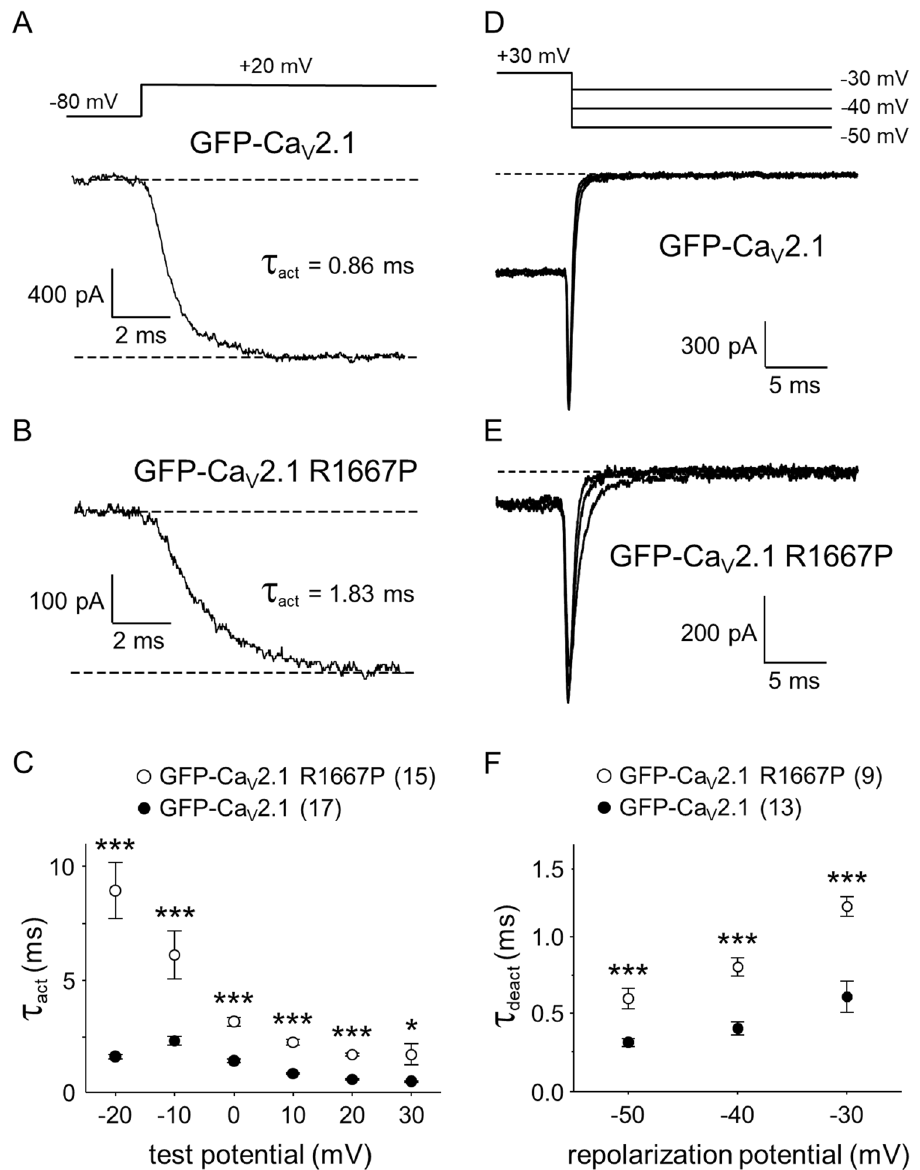
Figure 3. The R1667P mutation slows activation and deactivation. Ca 2+ currents were recorded from